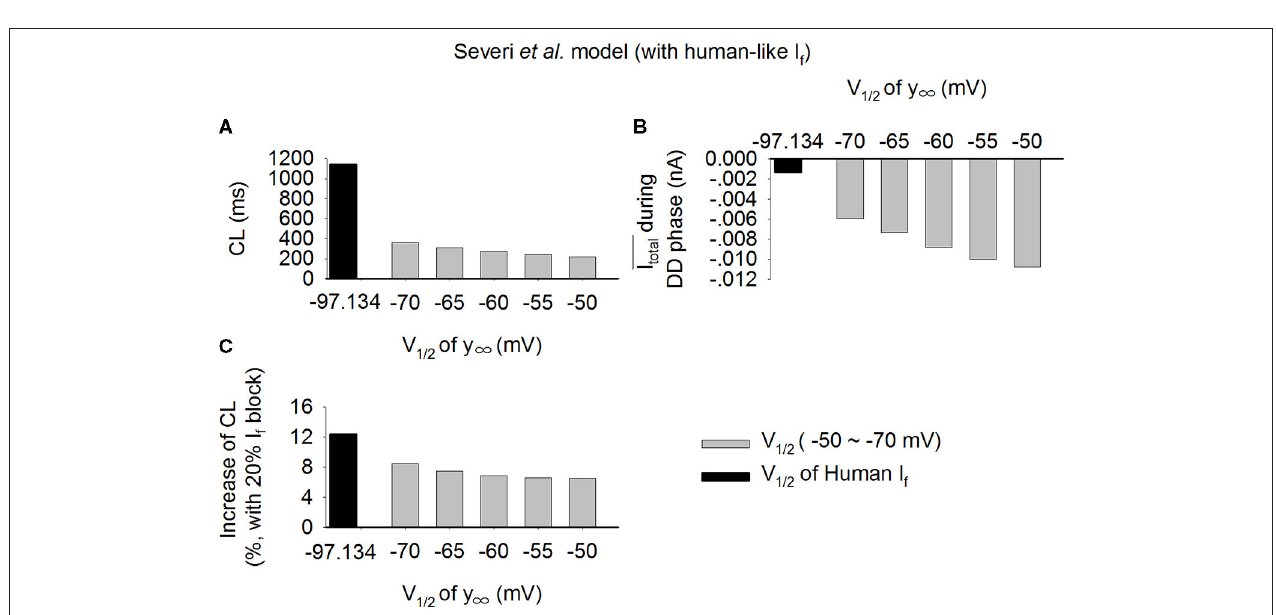
· 1 and 1 | FIGURE 8 | Computed values of 1 | | 1 / x − p | to validate theoretical analysis result (Equation 2) in method section ( p I total | 1 / x − p | The highlighted lines shown in this figure are during the diastolic depolarization phase of the action potentials of control (solid lines) and 20% I f reduction (dotted lines) cases for the rabbit-like (Ai,Bi) and human-like (Aii,Bii) SAN cell models.